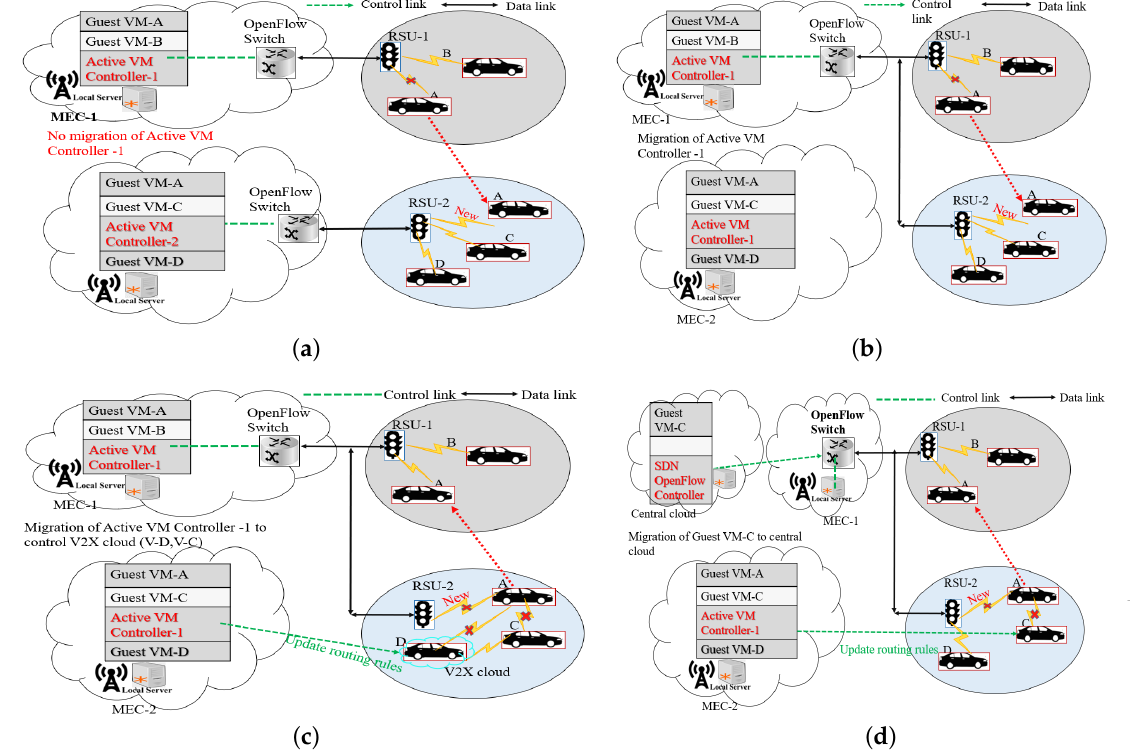
Figure 7. Active Controller migration scenario in the Software cloud vehicular network: ( a ) inter-MEC migration case; ( b ) intra-MEC VM migration case; ( c ) across MEC micro-data computing; and ( d ) across MEC and central